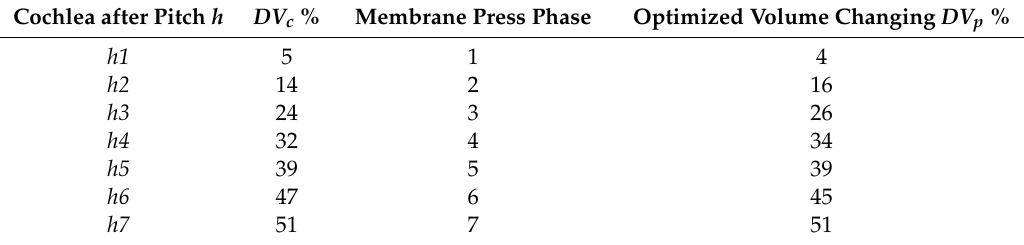
Table 4. DV c and DV p volume changing evaluated, in % respect to the initial value V 0 , respectively, for the cochlea after every pitch and for the optimized membrane press after every